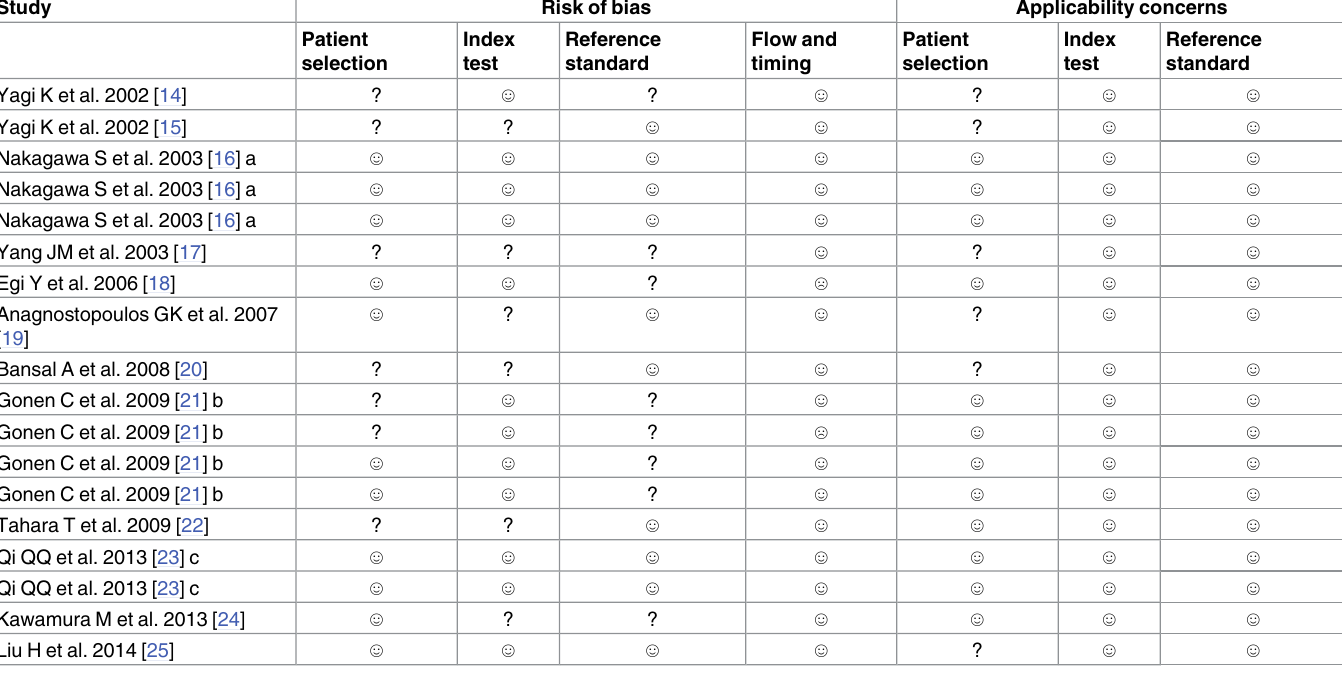
Table 2. The Quality Assessment of Diagnostic Accuracy Studies-2 (QUADAS-2) tool for quality assessment of studies selected for the meta- analysis.